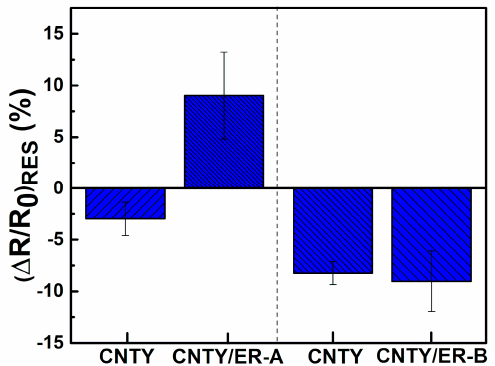
Figure 7. Normalized residual electrical resistance of CNTY/ER-A, CNTY/ER-B and their corresponding freestanding CNTYs under the same temperature program.